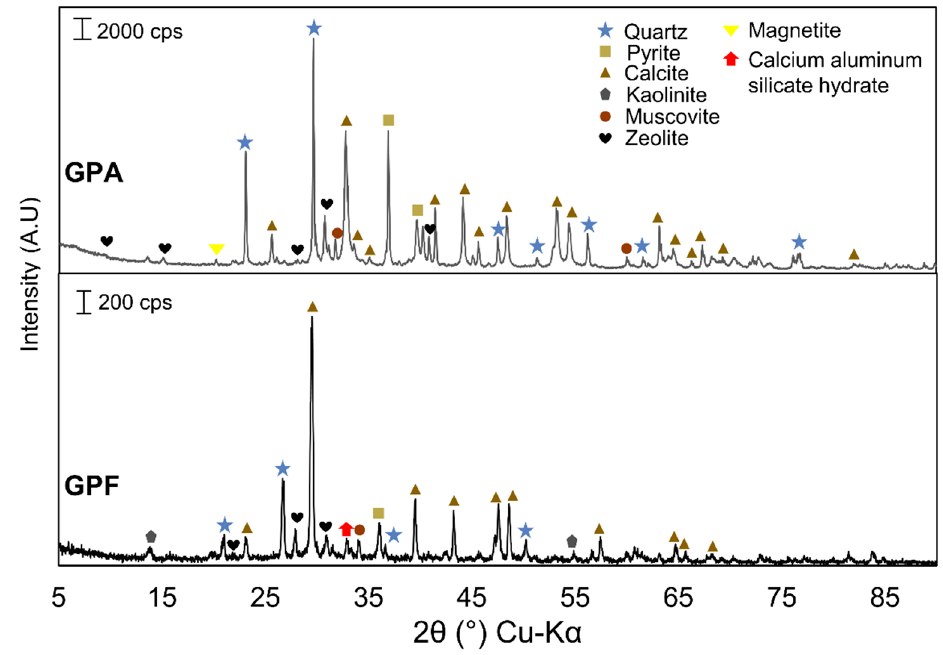
Figure 5. XRD patterns of synthesized geopolymer composites without POFA (GPA) and with POFA (GPF). POFA